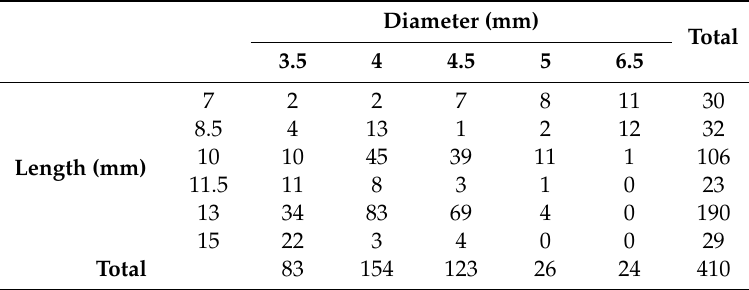
Table 1. Frequency of implant length and implant diameter.